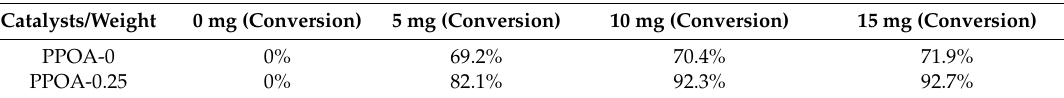
Figure 4. UV–Vis absorption spectra for filtrate of PPOA-0 and PPOA-0.25. The left insert image is the structural formula of Congo red, and the right insert image is the color of the filtrate of the Congo red solution with PPOA-0 and PPOA-0.25. Table 2. The conversion of indene by PPOA-0 and PPOA-0.25 with different weights after 60 min of the reaction.